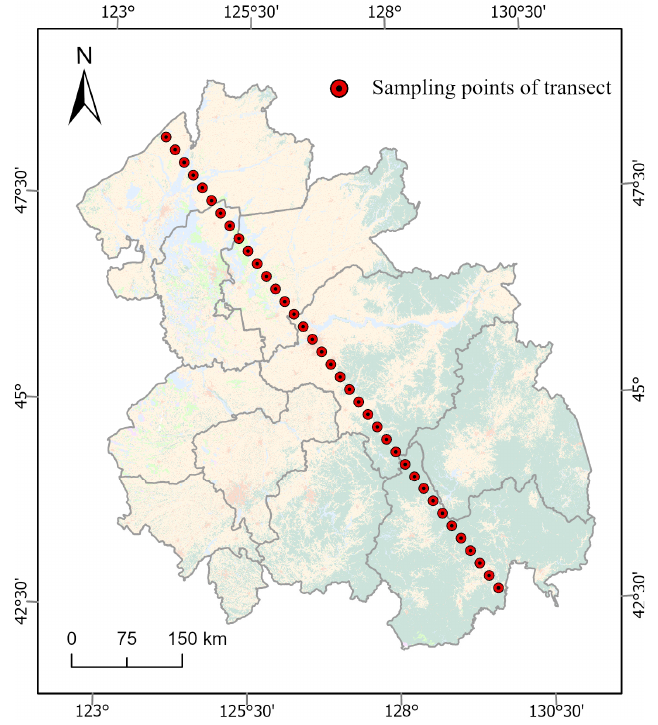
Figure 4. Sampling points of the transect.